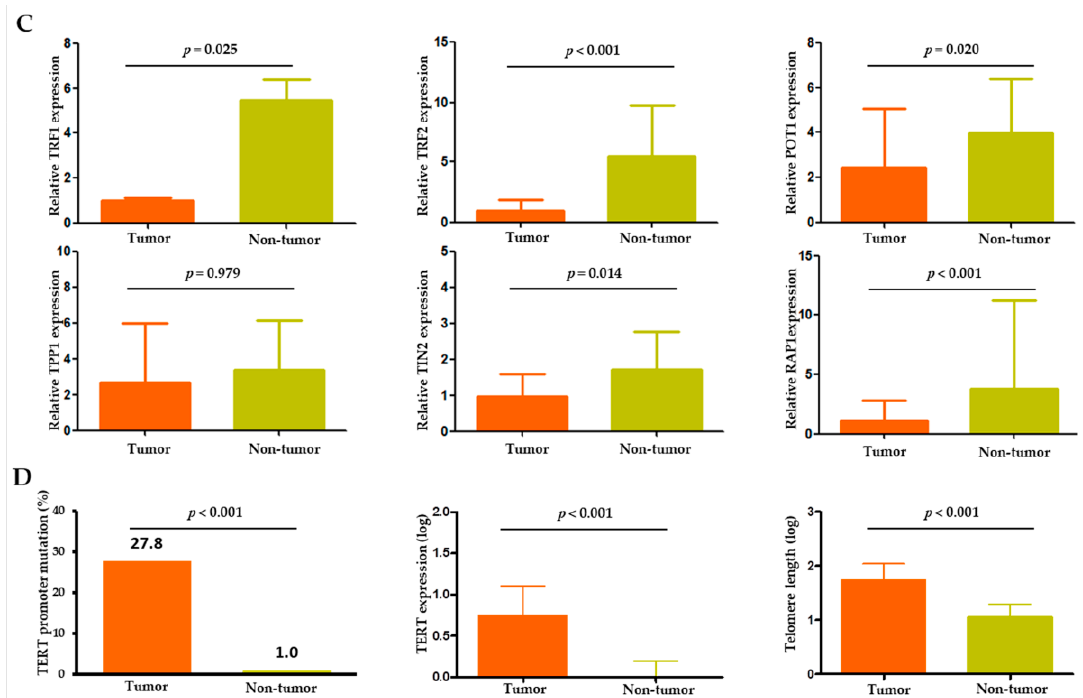
Figure 1. TERT expression and telomere length relationship in HCC. ( A ) Protein–protein interaction (PPI) analysis of TERT using the CBS probe PINGS TM in HCC tissues. ( B ) Expression profiles of the eight TERT -interacting genes from the STRING database in tumor versus adjacent non-tumor tissues. ( C ) Comparison of shelterin complex TRF1, TRF2, POT1, TPP1, TINP2, and RAP1 between tumor and non-tumor tissues. ( D ) Comparison of TERT promoter mutations, TERT expression and telomere length between tumor and non-tumor tissues. TRF, telomeric repeat-binding factors; POT1, protection of telomeres 1; TPP1, POT1-TIN2 organizing protein; TIN2, TRF1 and TRF2 interacting nuclear protein 2; RAP1, repressor/activator protein 1. NS, non-significance; *** p < 0.001.